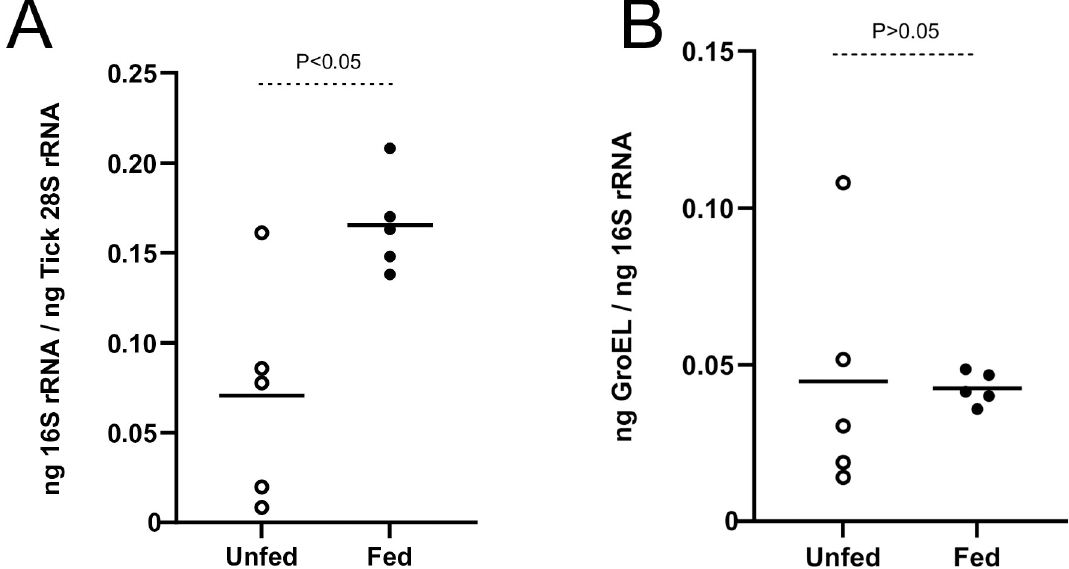
Fig 6. Blood feeding induces Occidentia- like species 16S rRNA levels in O . turicata americanus ticks. QRT-PCR analysis with RNA showing levels of Occidentia -like species 16S rRNA (A) and groEL (B) transcript levels in unfed and fed O . turicata americanus nymphal ticks. Occidentia -like species 16S rRNA levels were normalized to O . turicata americanus 28S rRNA levels. Levels of Occidentia -like species groEL transcripts were normalized to levels of Occidentia -like species 16S rRNA. Each open and closed circle represents data from one individual tick. Statistical analysis was performed with Student’s t test and P value less than 0.05 was considered as